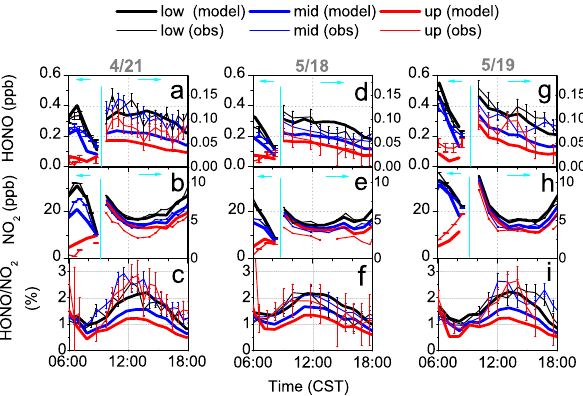
Fig. 4. Comparisons between observations and model results with a photolytic HONO source at the ground. Shown here are daytime HONO (a, d, g) , NO 2 (b, e, h) , and HONO/NO 2 ratios (c, f, i) in the lower (black), middle (blue), and upper (red) height altitudes on 21 April (left panel), 18 May (middle panel), and 19 May (right panel). HONO and NO 2 mixing ratios after 09:00CST were magnified with a different scale on the right axis.